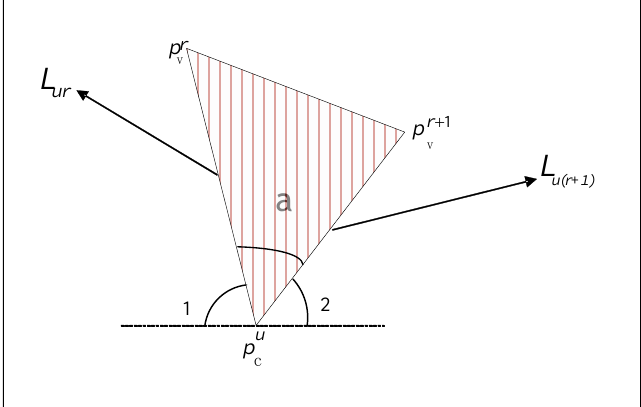
Figure 8. Triangle diagram of the lines connecting adjacent peaks and the related trough.